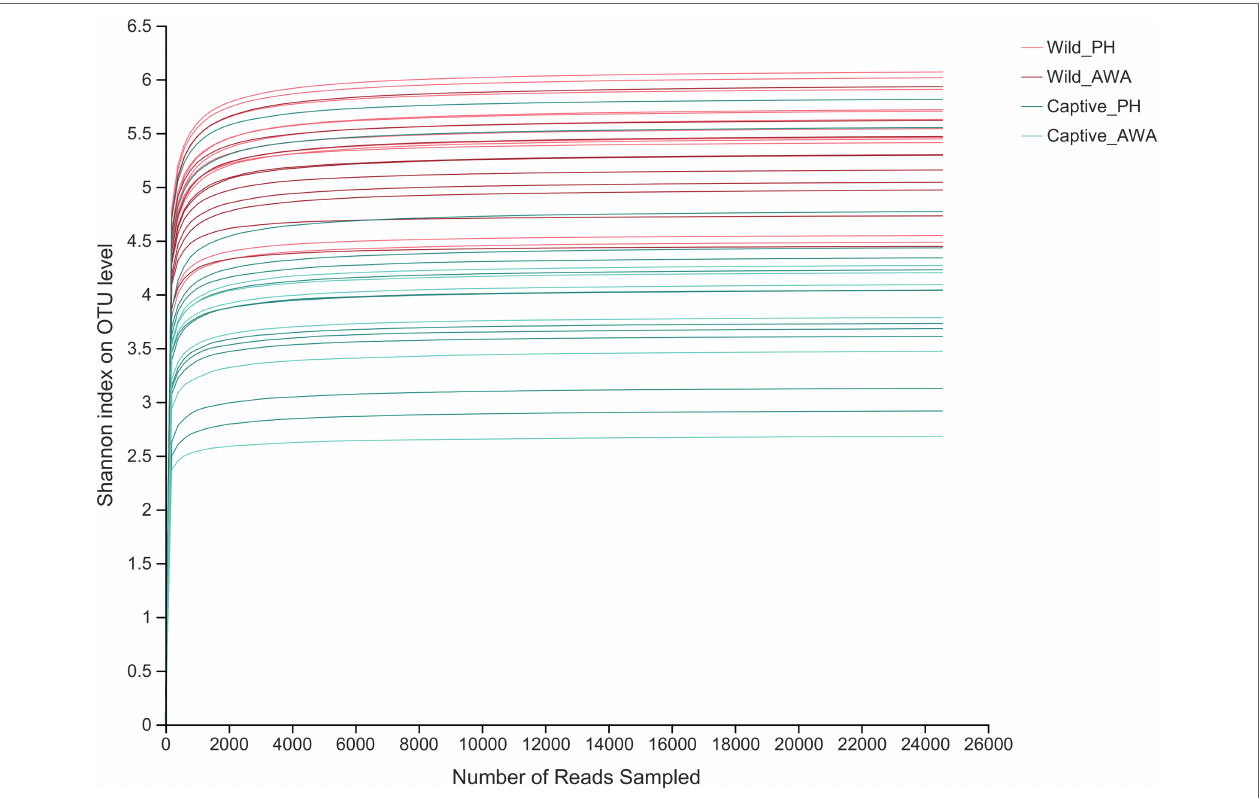
FIGURE 1 | Shannon index’s Alpha diversity rarefaction curves on the OTU level. The abscissa represents the number of reads selected randomly; the ordinate represents the Alpha diversity